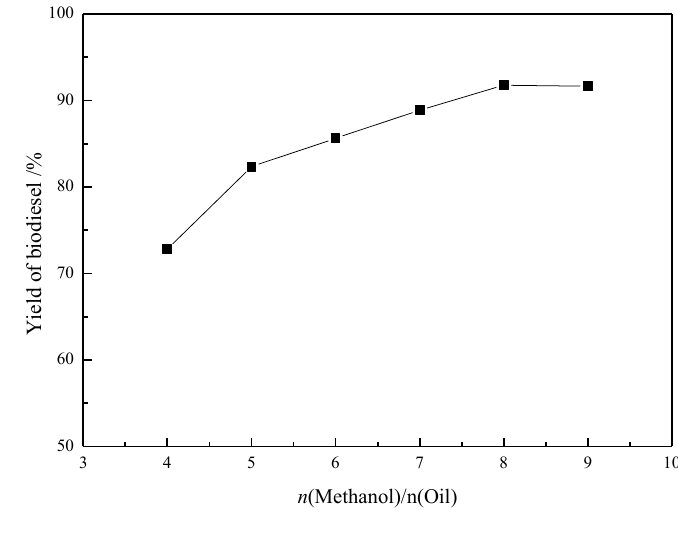
Figure 4. Effect of n (Methanol)/ n (Oil)on the yield (y) in preparation of biodiesel catalyzed by [Hnmm]OH. Reaction conditions: w ([Hnmm]OH = 3%); T = 70 °C; t = 2